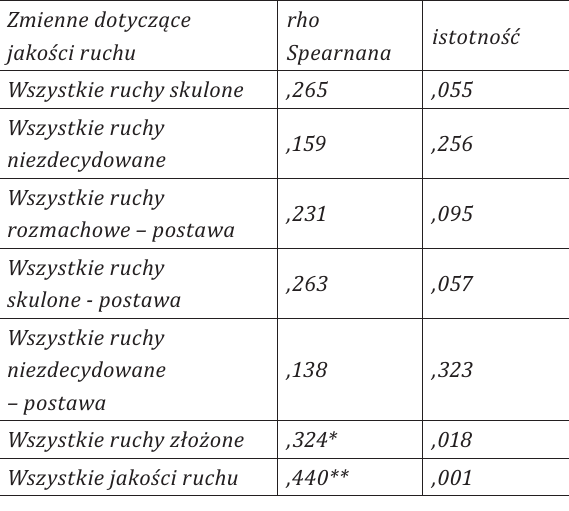
Tabela 13. Wartości rho Spearnana między zmienną „światłocienie” a zmiennymi dotyczącymi jakości ruchu w grupie wszystkich matek